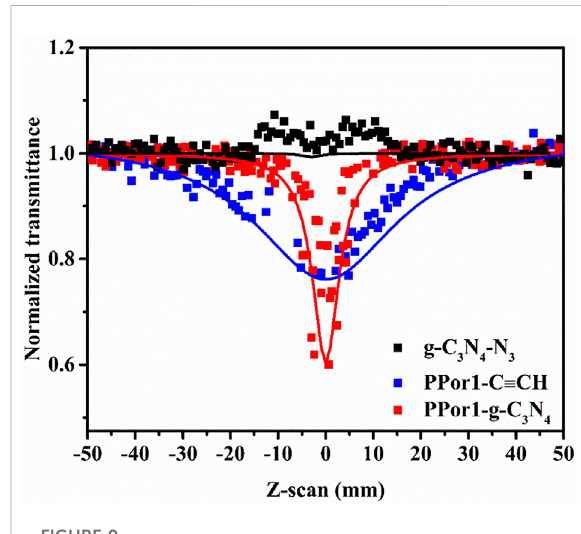
FIGURE 9 The open aperture Z-scan tests of g-C 3 N 4 -N 3 , PPor1-C ≡ CH and PPor1-g-C 3 N 4 in MMA (0.05 mg/ml).